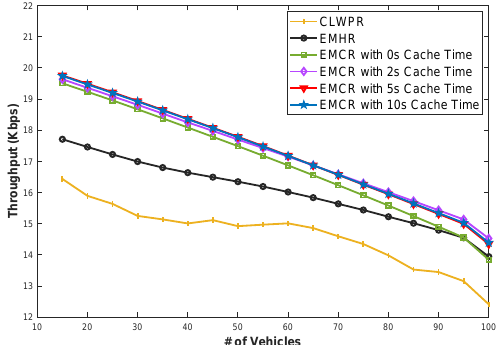
Figure 13. Throughput vs. Number of